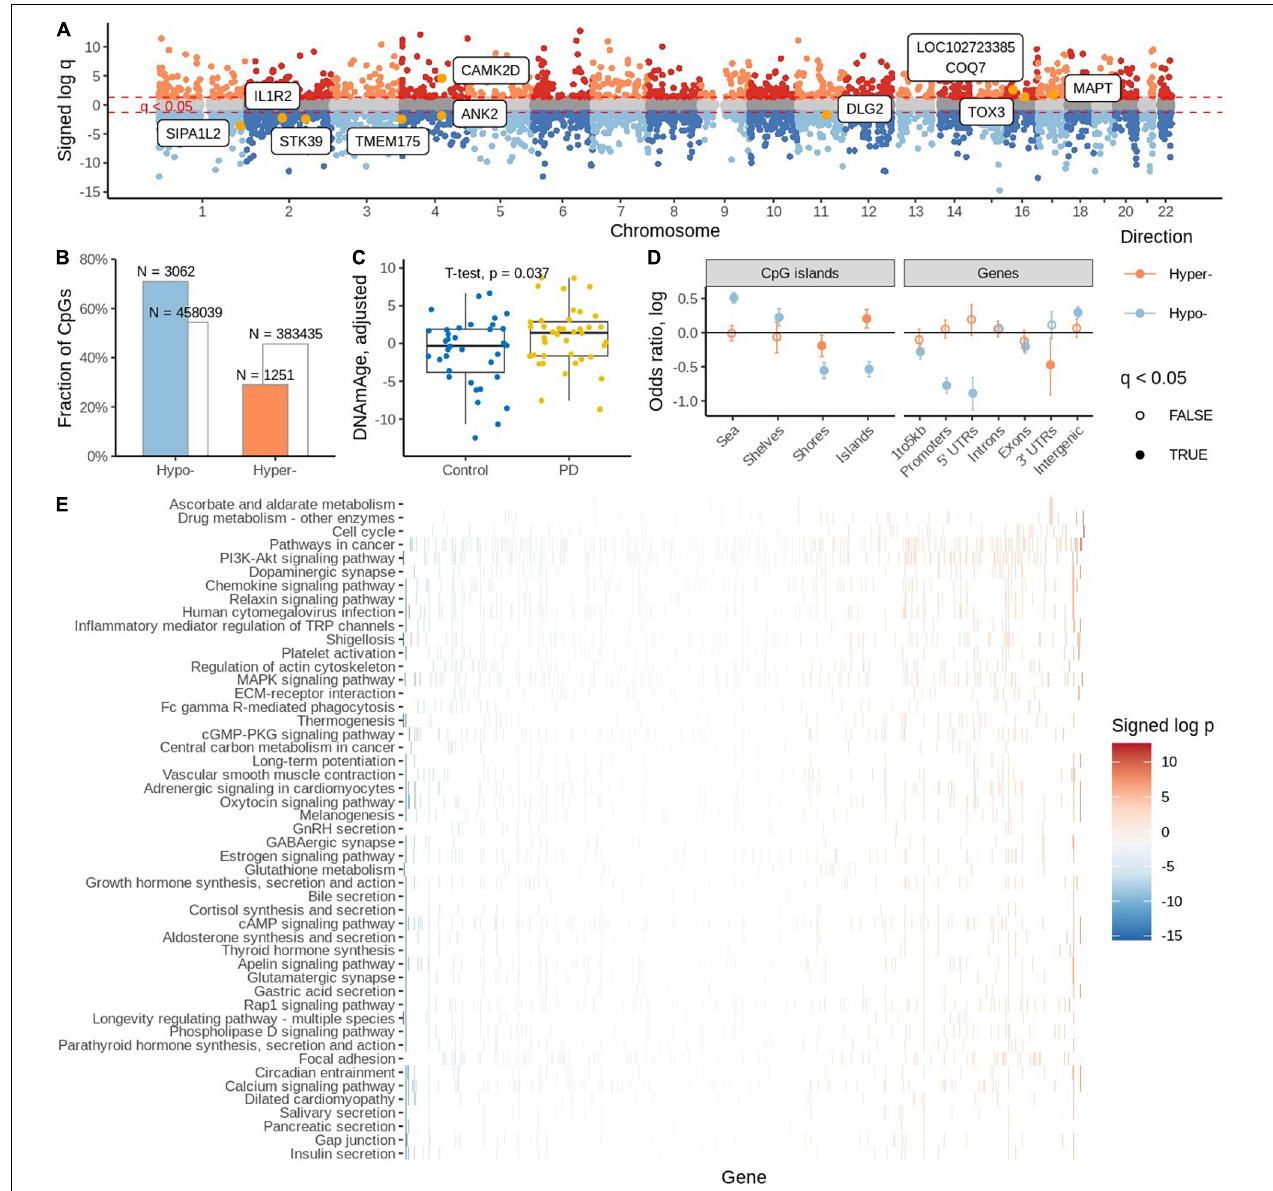
FIGURE 2 | (A) Differentially methylated sites with known PD GWAS genes. (B) Significantly differentially methylated (hyper and hypo) probes. (C) Estimation of DNA methylation age. (D) Distribution of significantly differentially methylated cytosines in various genomic areas. (E) Estimation of gene set enrichment of KEGG